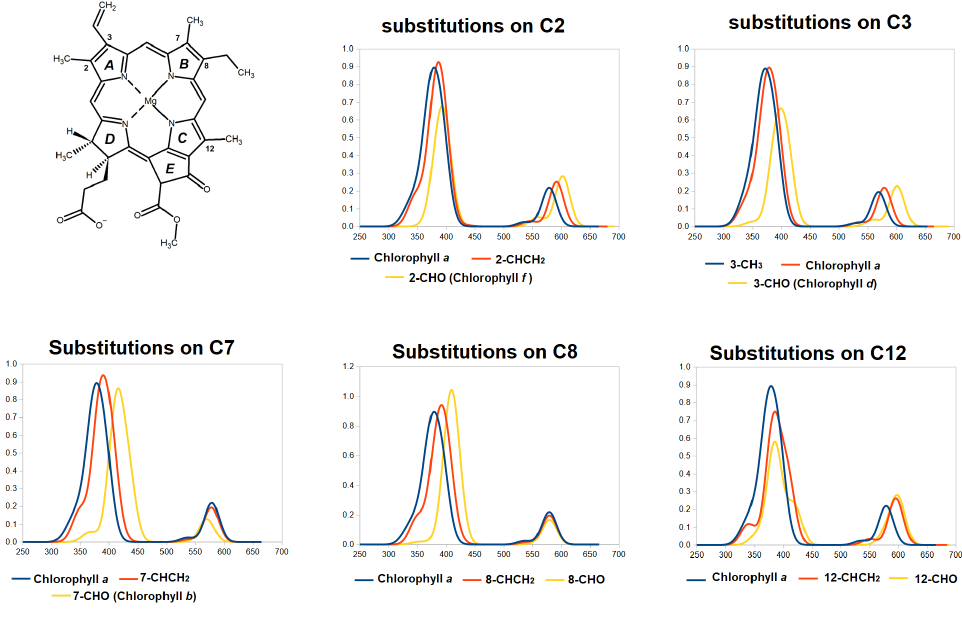
Figure 4 TDDFT-predicted spectra (PBE0/6-31G*) of selected derivatives of chlorophyll a . In each graph, the spectrum of the derivative bearing a methyl (or ethyl, for position 8) at the given position is de- picted in blue. Spectra of derivatives bearing a vinyl group at that position are depicted in red, and those of molecules bearing formyl at that position are depicted in yellow. Full-size DOI: